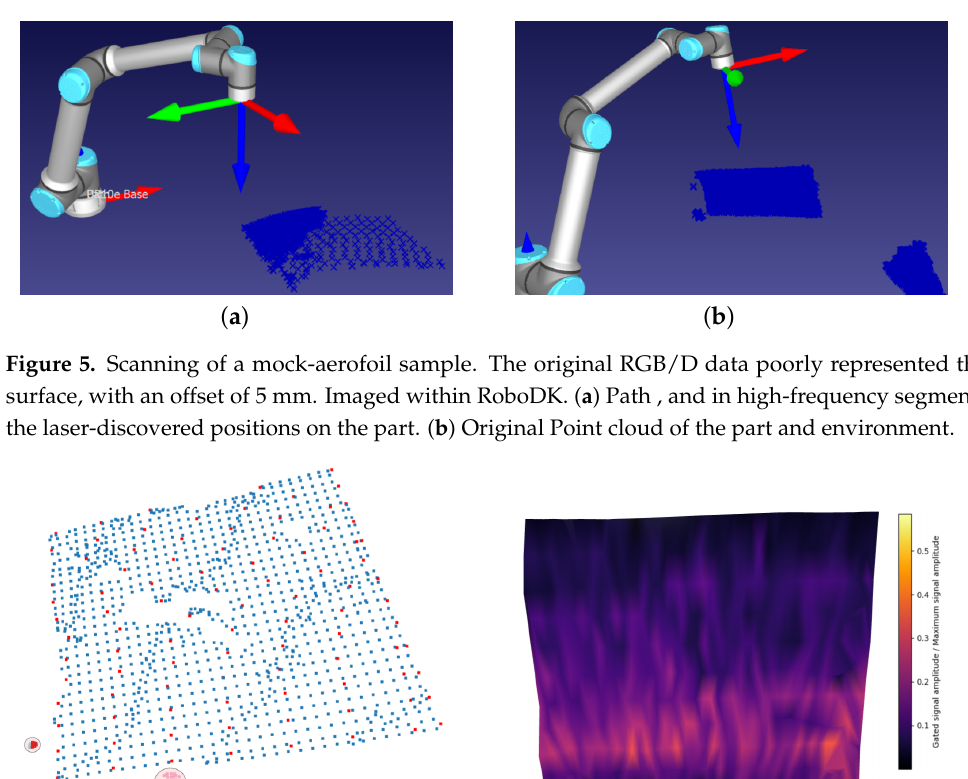
Figure 4. Scanning of a mock-aerofoil sample. The original RGB/D data poorly represented the surface, with an offset of 5 mm. ( a ) Robotic-arm deployed to a mock aerofoil with large surface curvature. ( b ) Surface reconstructed using laser-data, waypoints from the RGB/D image embedded.